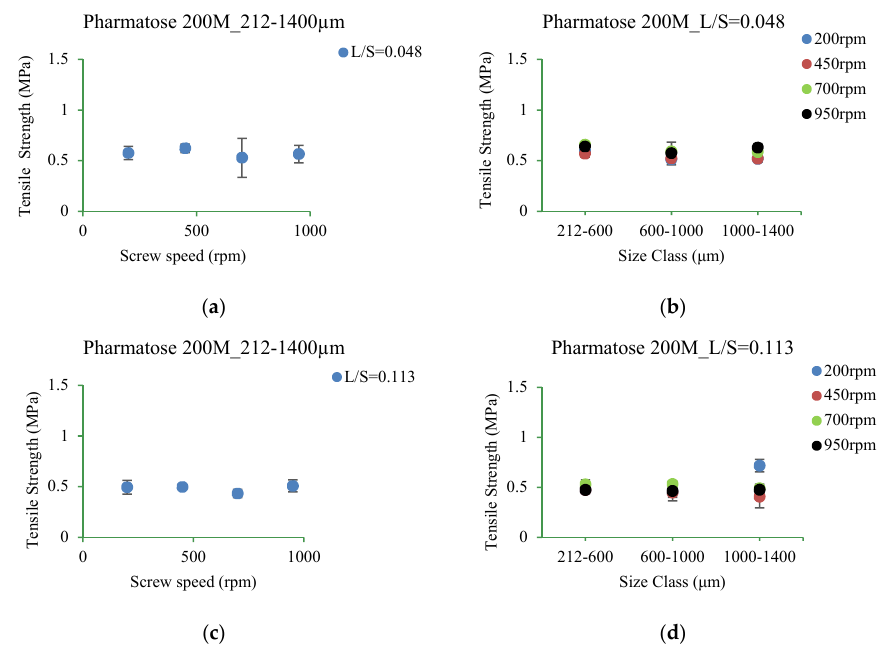
Figure 15. Tensile strength of tablet of granules at different size classes of Pharmatose